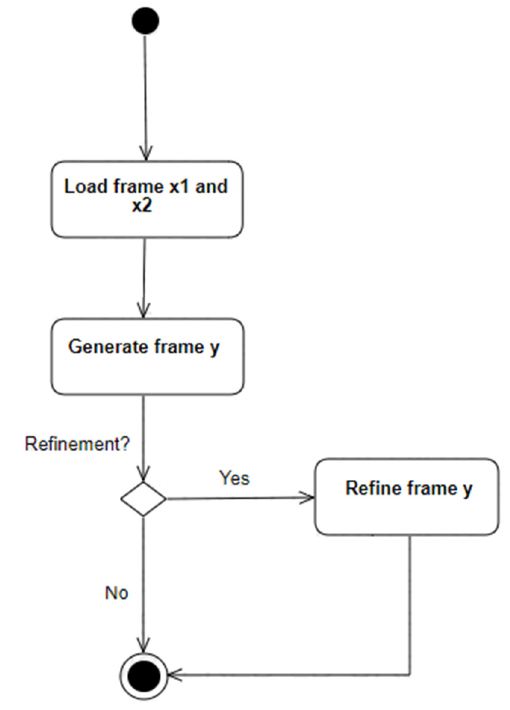
Figure A1. The activity diagram of the process of interpolation. The frame interpolation network produces an output frame from two given input ones. Then, the optional refinement step involves for further improvement.